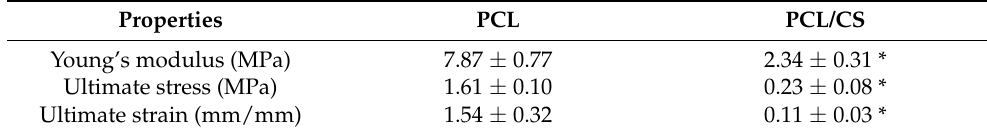
Figure 2. The typical tensile stress–strain curves of PCL and PCL/CS nanofiber membranes. Table 2. The mechanical properties of PCL and PCL/CS nanofiber membranes from tensile testing (mean ± SD, n = 3).